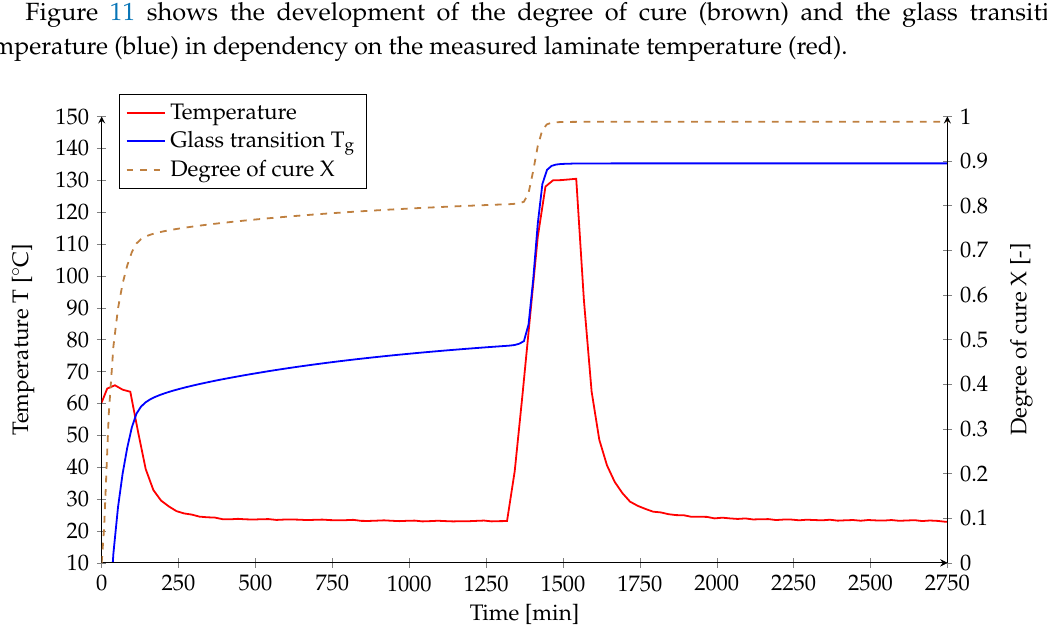
Figure 11. Calculated development of degree of cure and glass transition temperature in dependency on the measured laminate